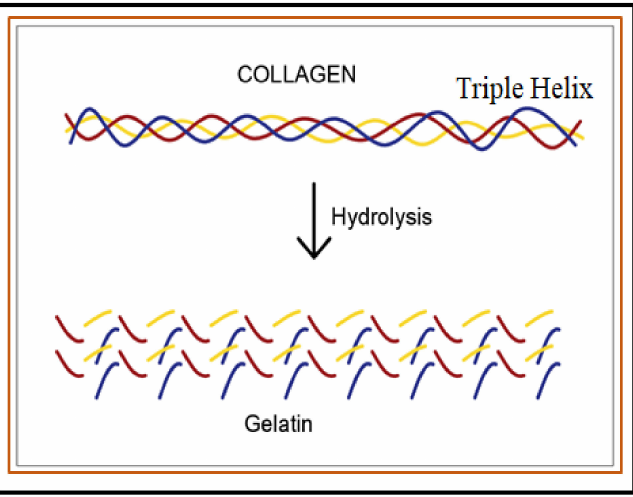
Figure 3. A change in collagen polymer structure during hydrolysis.